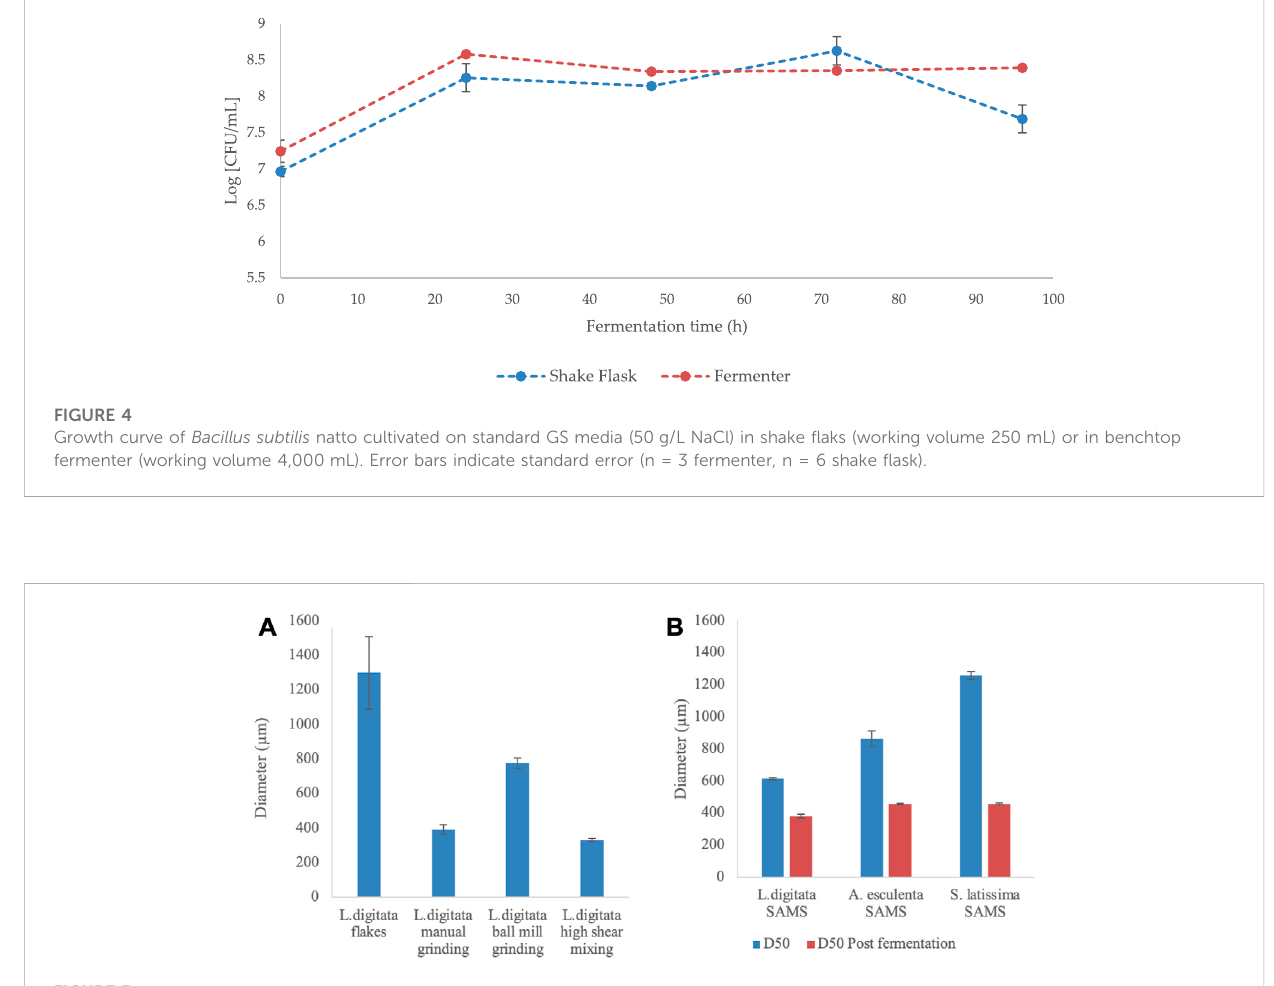
FIGURE 5 Average diameter [Dx (50)] of algal samples undergone different mechanical pre-treatments. (A) Mechanical processing of commercially available Laminaria digitata fl akes (B) Variation in diameter of particles provided by Scottish Association for Marine Science (SAMS - Oban, UK) before and after production of γ -PGA. All samples are the average of fi ve replicates processed by the